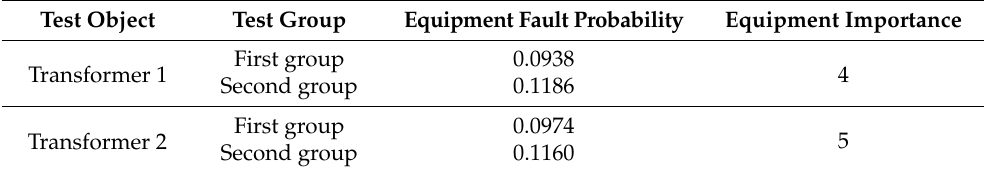
Table 6. Transformer corresponding to equipment fault probability and importance.